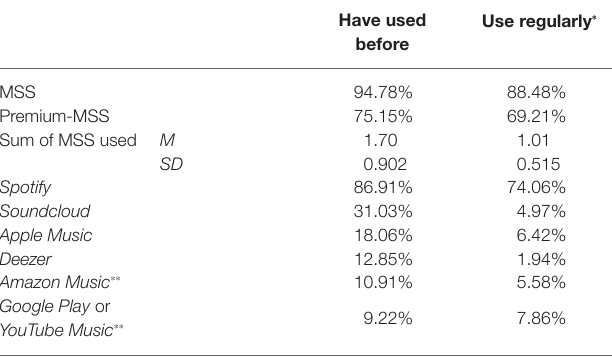
TABLE 2 | Usage of music streaming